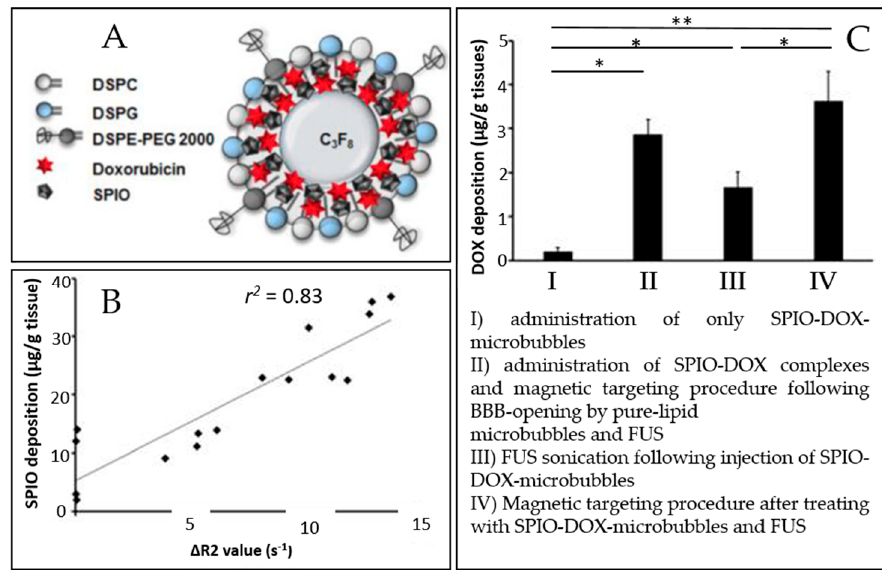
Figure 6. An example of a multimodal agent for BBB disruption, MRI, and drug delivery purposes (extracted from Fan et al. [109], Ivyspring International Publisher, 2016). ( A ) Illustration of SPIO-DOX-microbubble structure. ( B ) Correlation between SPIO deposition and ∆ R2 value. ( C ) DOX accumulation measured by high-performance liquid chromatography. *: p < 0.05; **: p < 0.01.